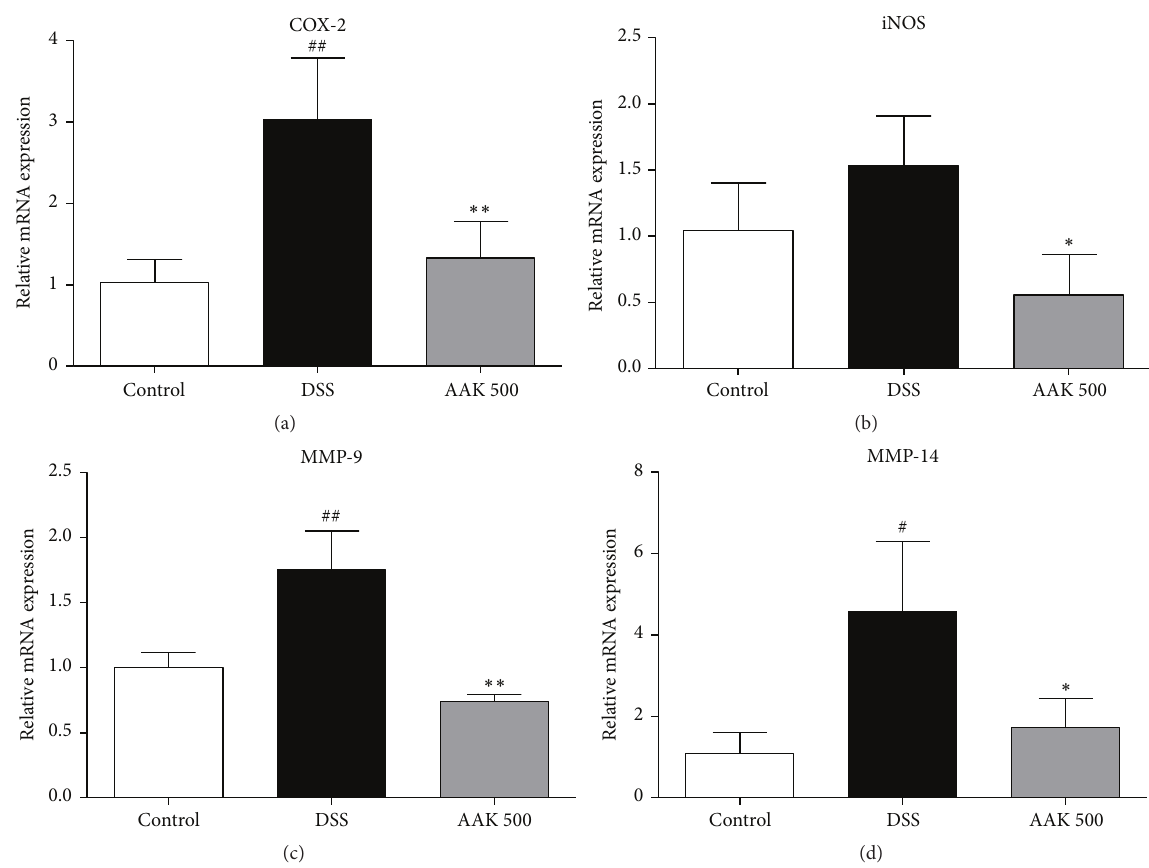
Figure 6: Effects of AAK extract on the gene expression levels of inducible enzymes and MMPs in DSS-induced colitis. (a–d) mRNA expression of COX-2, iNOS, MMP-9, and MMP-14 was measured by real-time PCR, and GAPDH was used as an endogenous control. Fold- changes are expressed as the mean ± SD ( 𝑛 = 4 – 6 per group). # 𝑝 < 0.05 and ## 𝑝 < 0.01 versus control; ∗ 𝑝 < 0.05 and ∗∗ 𝑝 < 0.01 versus